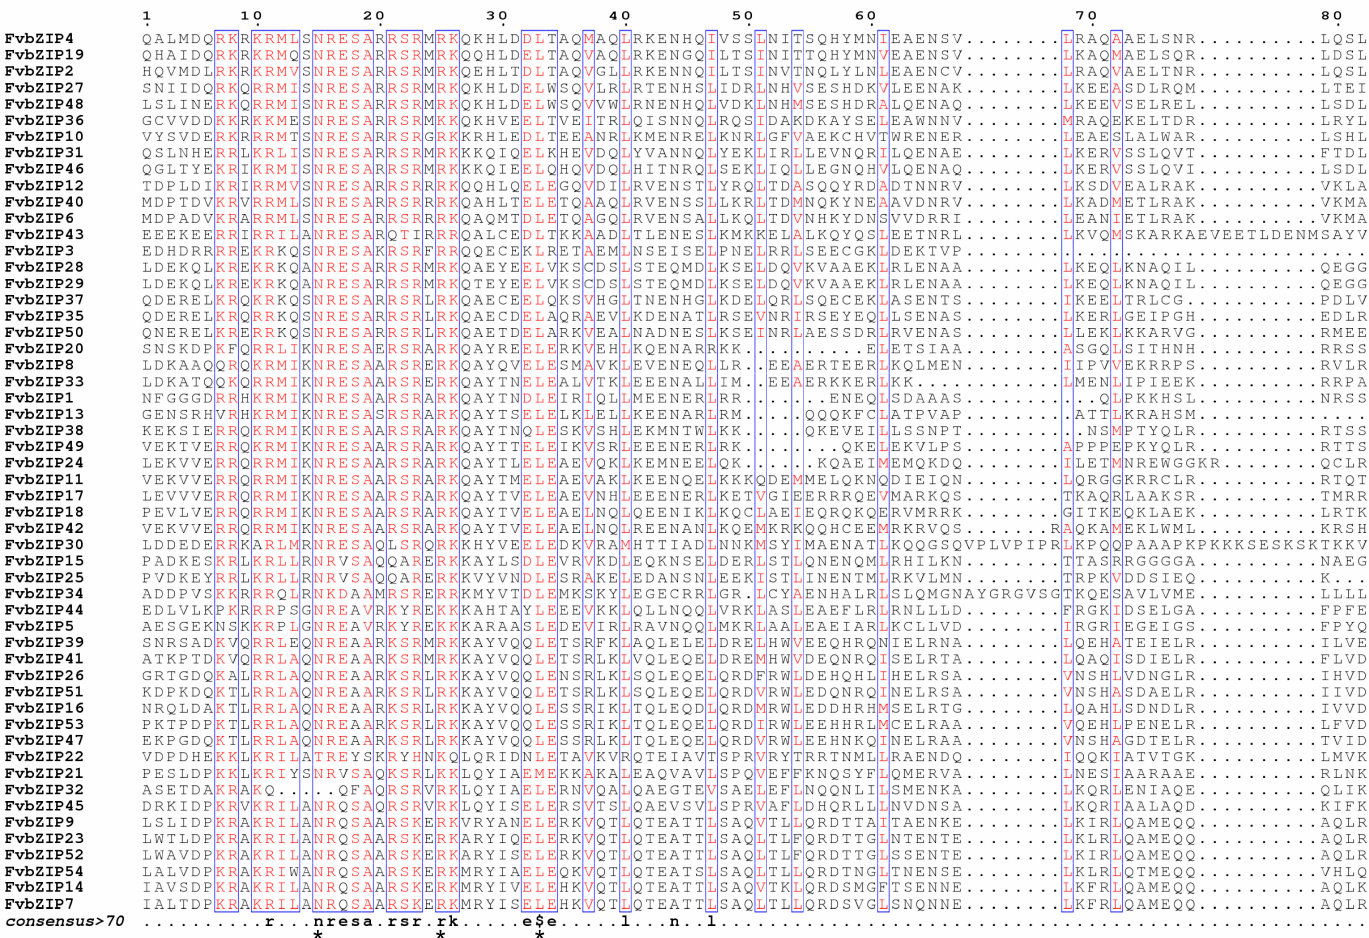
Figure 3. Multiple alignments of conserved domains of all identified FvbZIP proteins. Asterisks show the conserved amino acids of the bZIP domain.